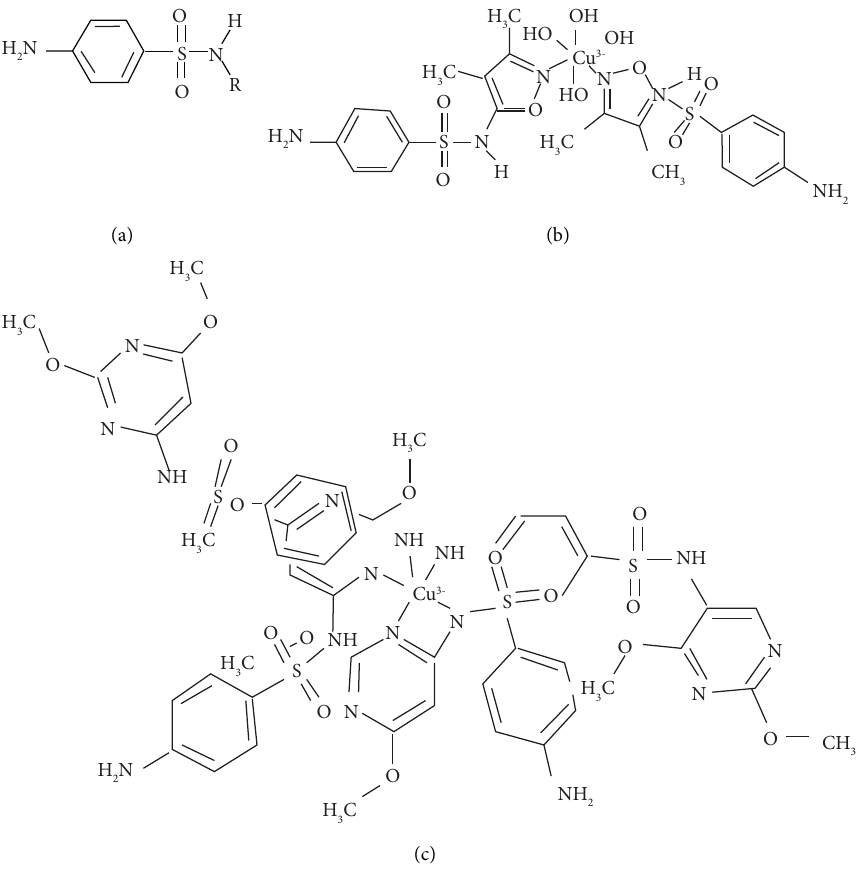
Figure 4: (a) General structure of sulfonamides; (b) structure of [Cu (sulfsoxazole) 2 (H2O)4 ] • 2H2O7, the two oxazole rings and the copperion are in the same plane; (c) structure of a six-membered heterocycle substituted sulfonamide with its environment